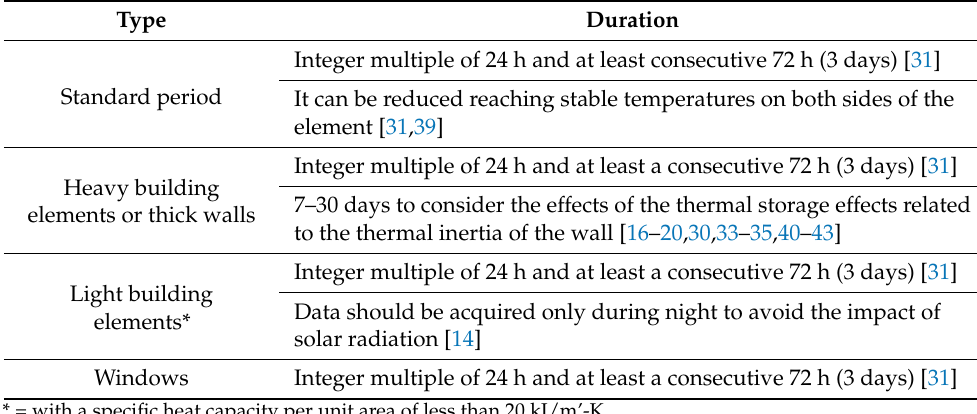
Table 7. Monitoring period for HFM measurement (source: authors’